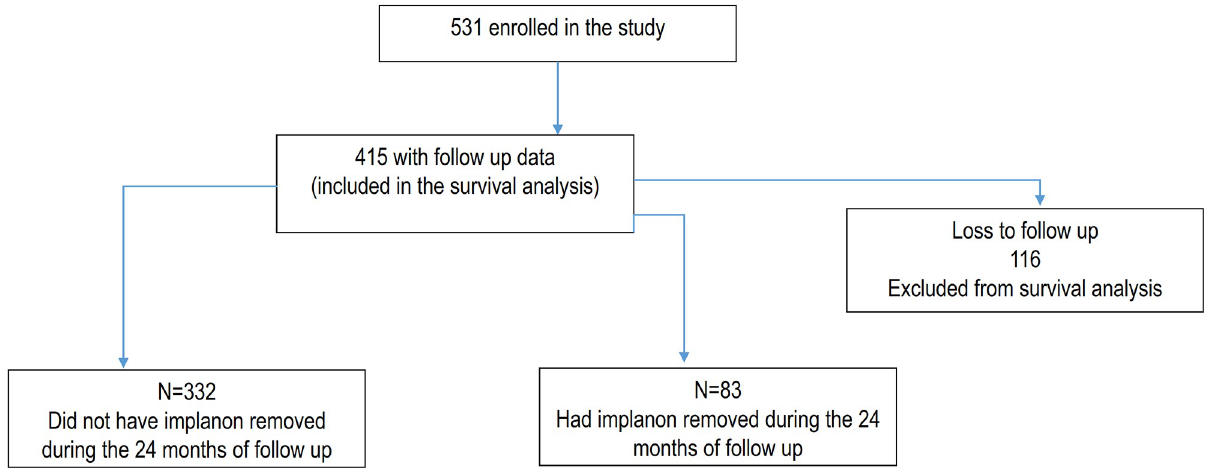
Fig 1. Flow diagram showing the way follow-up of participants was done from the insertion end point.